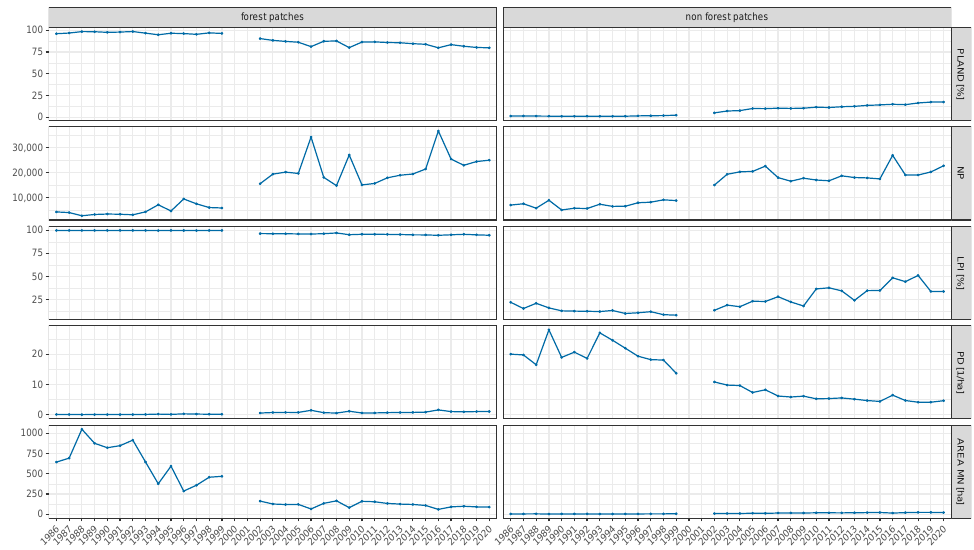
Figure 11. Line plot of the computed landscape metrics of the forest and nonforest mask for the municipality of Colniza between 1986 and